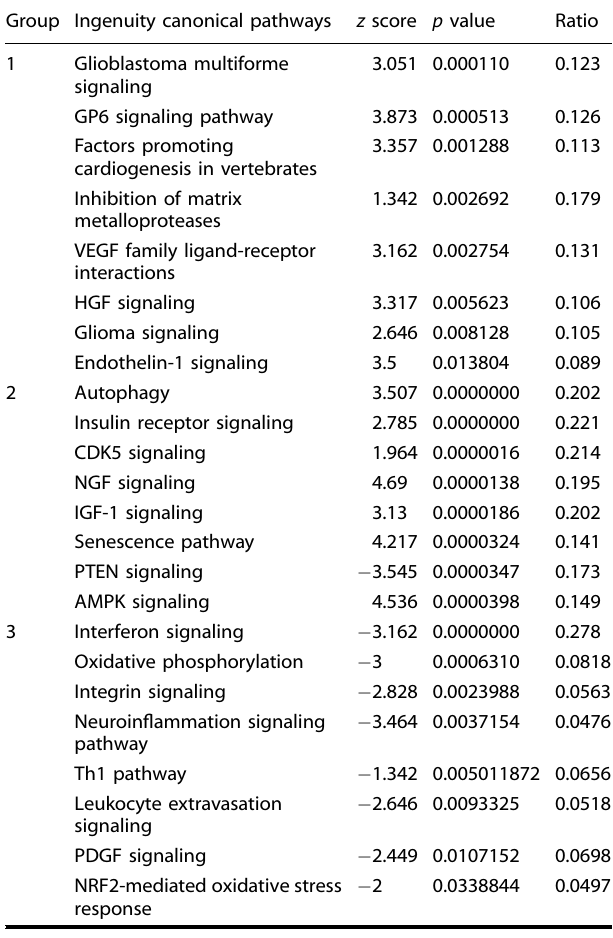
Table 3. Ingenuity pathway analysis of the genes from each group. Group Ingenuity canonical